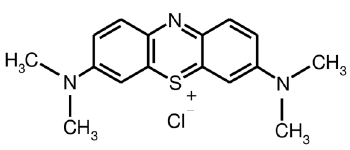
Figure 1. Chemical structure of MB